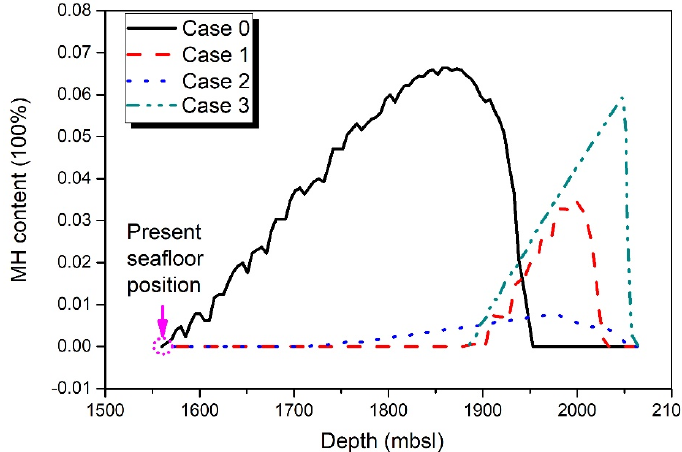
Figure 13. MH existence in four representative geological scenarios.